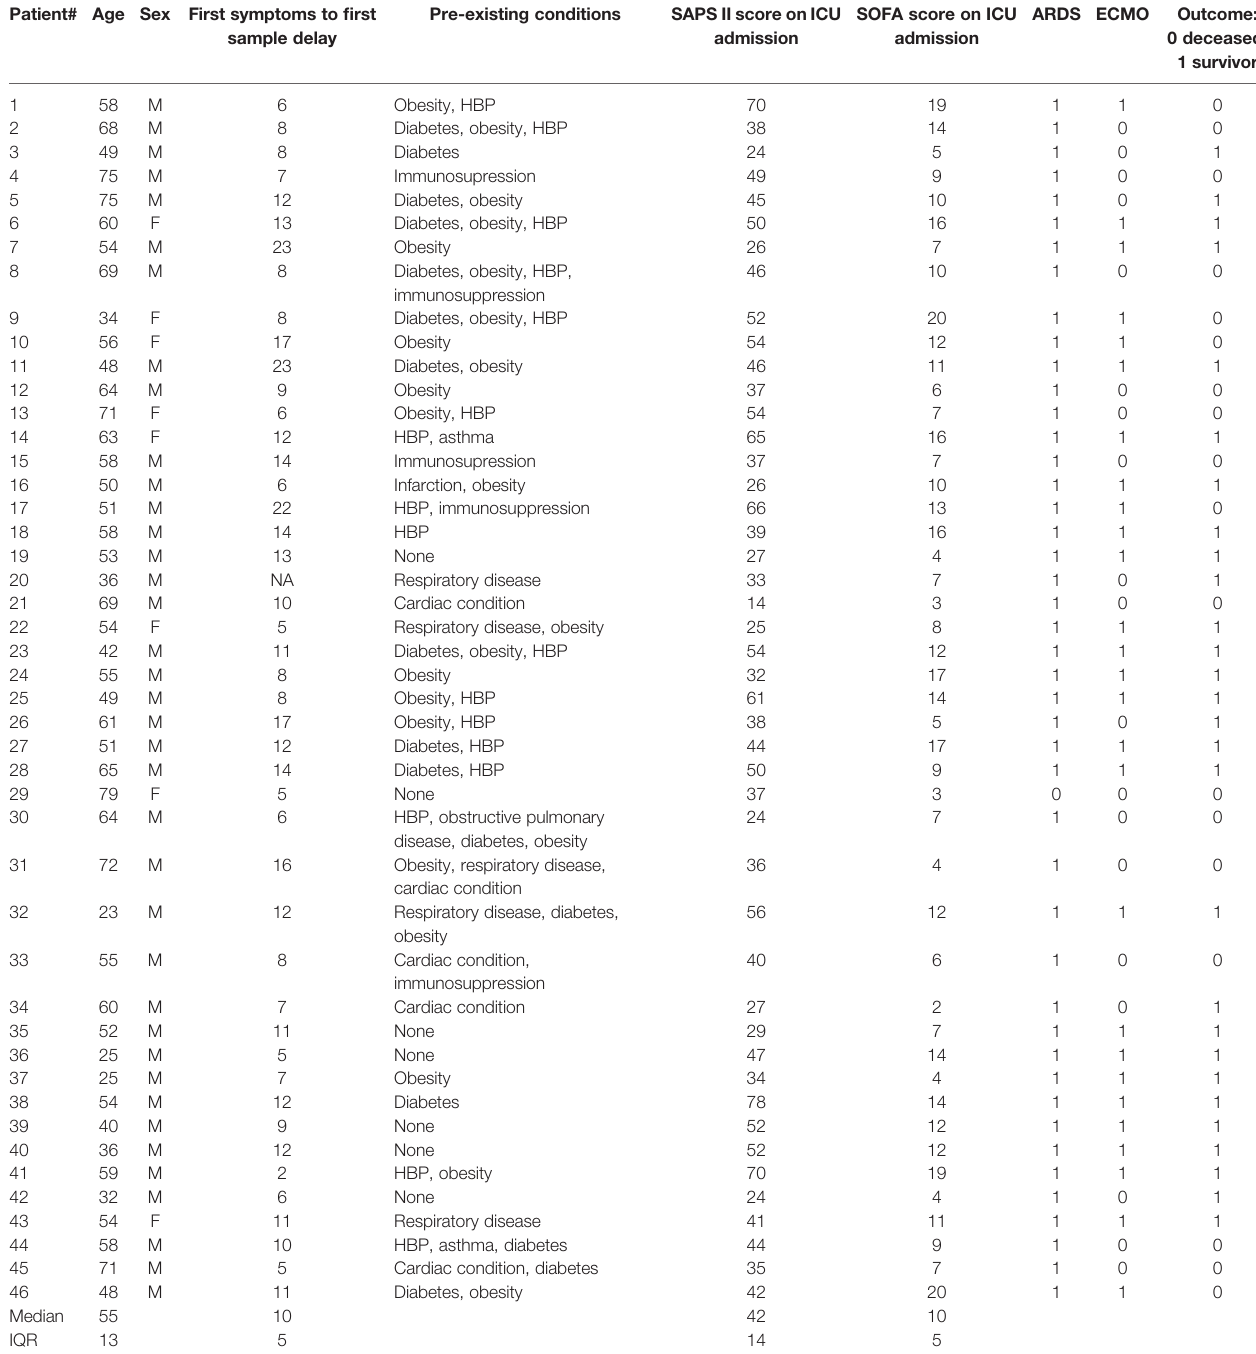
TABLE 1 | Very severe ICU patients with COVID-19 infection: fi rst wave. Patient# Age Sex First symptoms to fi rst sample